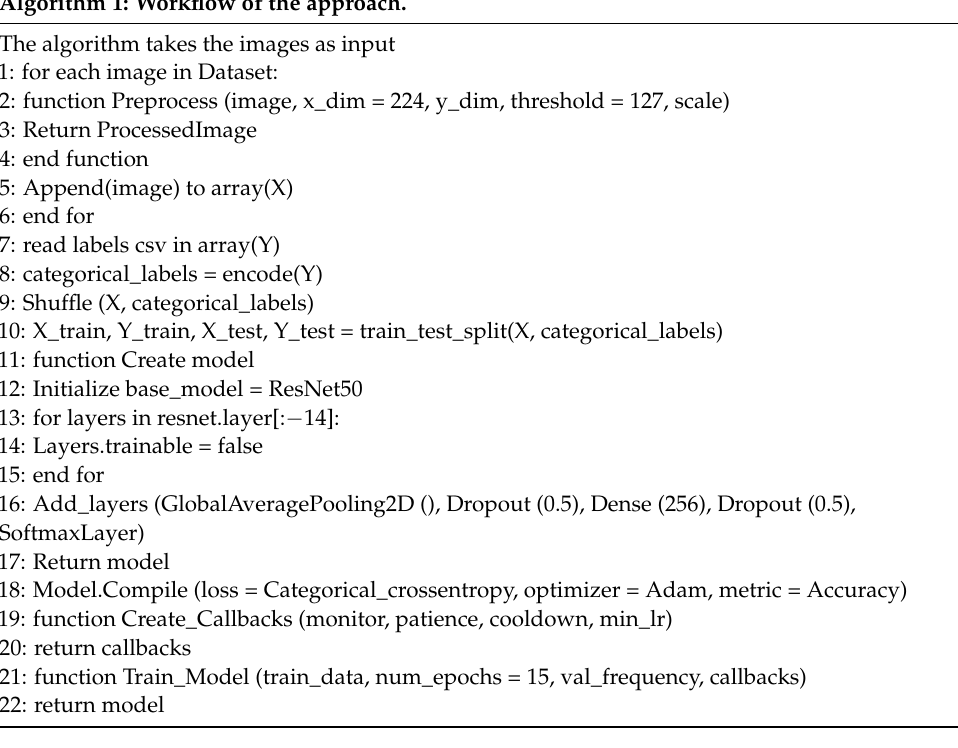
Algorithm 1: Workflow of the approach.